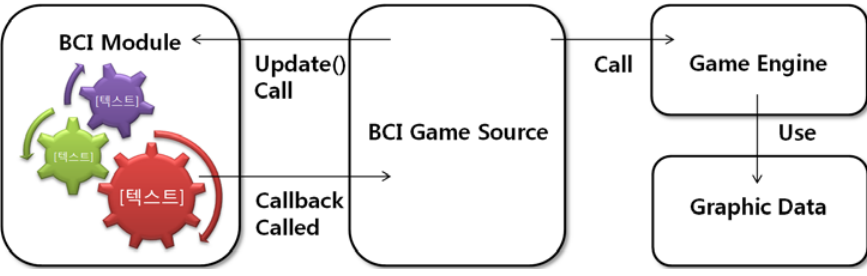
Figure 7. Program source diagram. The BCI module controls events via the update